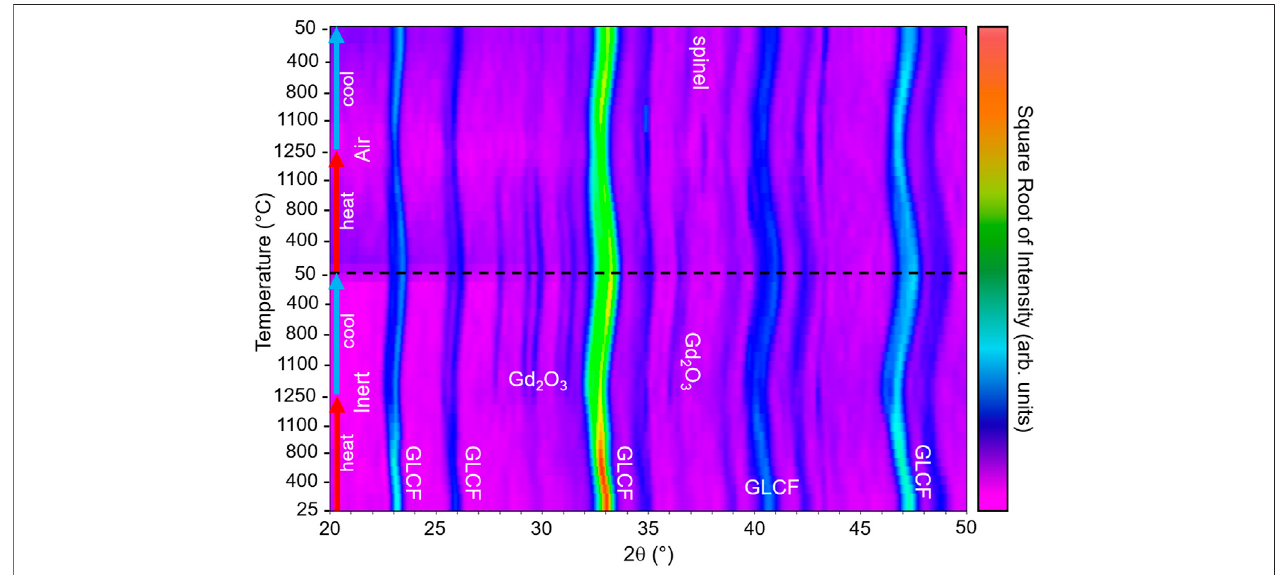
FIGURE5| HT-XRDpatternofGLCF,heatingfromroomtemperatureto1,250 ° Cthencoolingto50 ° CunderHe fl ow,followedbytheidenticalthermalpro fi leunder air. The experiment progresses from the bottom of the plot to the